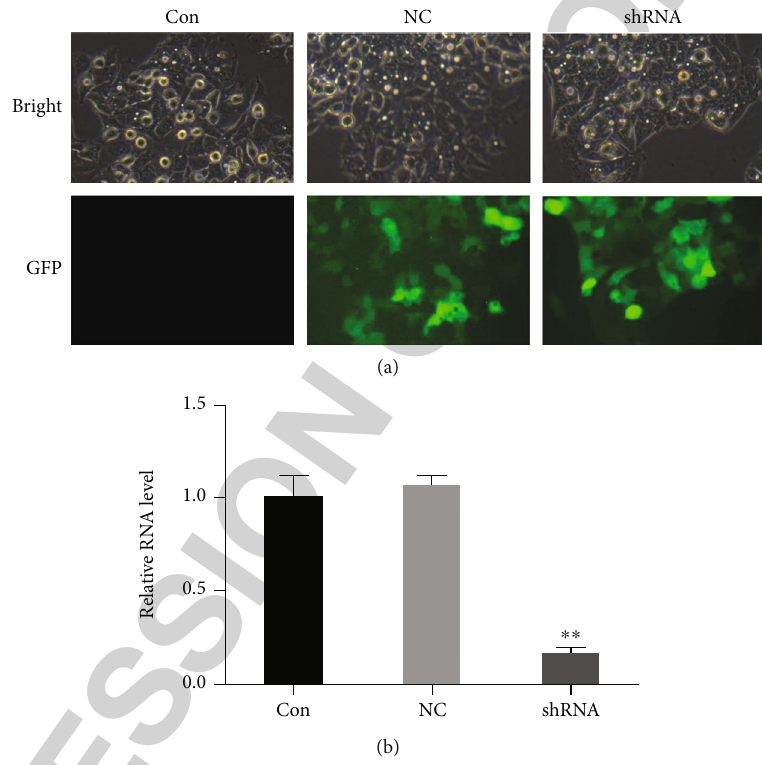
Figure 2: (a) The lentivirus containing LOXL1-AS1 shRNA or control shRNA infected the Hep-G2 cell line. Expression of GFP indicates the lentivirus e ffi ciency of infection in Hep-G2 cells (original magni fi cation × 20). (b) qRT-PCR manifested knockdown e ffi ciency of LOXL1-AS1 in the Hep-G2 cell line. The expression of β -actin was used as an internal control. Graph revealed mean ± SD . ∗∗ meant P < 0 : 01